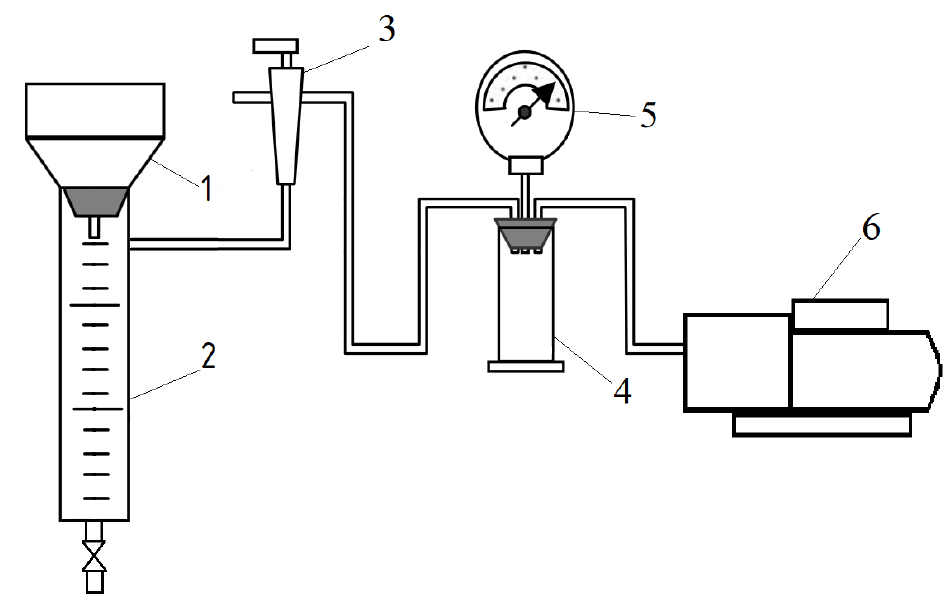
Figure 1. Diagram of a laboratory installation for dewatering and determining the specific filtration resistance. 1—Buchner funnel; 2—measuring cylinder; 3—shut-off valve; 4—receiver; 5—vacuum gauge; 6—vacuum pump.